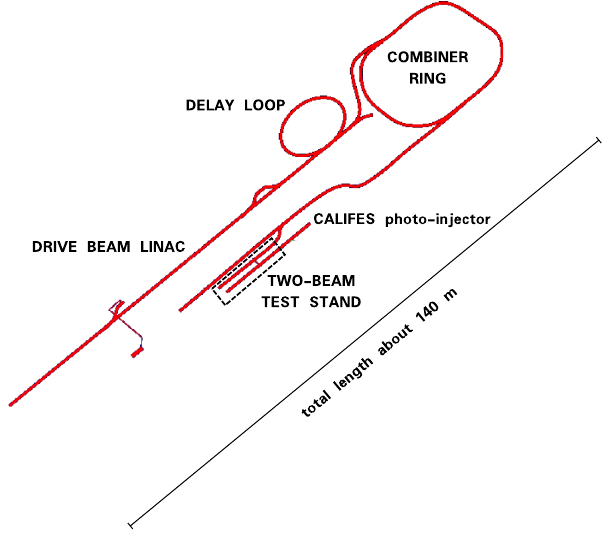
FIG. 1. Sketch of the CLIC Test Facility 3 at CERN. An electron drive beam is accelerated in a normal-conducting linac and its bunch frequency and current multiplied by means of a delay loop and a combiner ring. The beam is then sent to the Two-beam Test Stand experimental hall where the CALIFES linac is also installed to provide a second electron beam that is as well sent to the Two-beam Test Stand probe beam line for two-beam acceleration